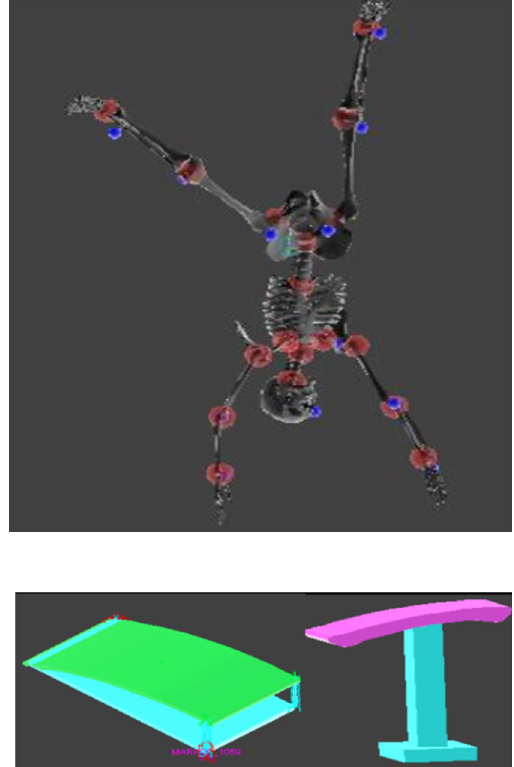
Fig. 7 Environmental model